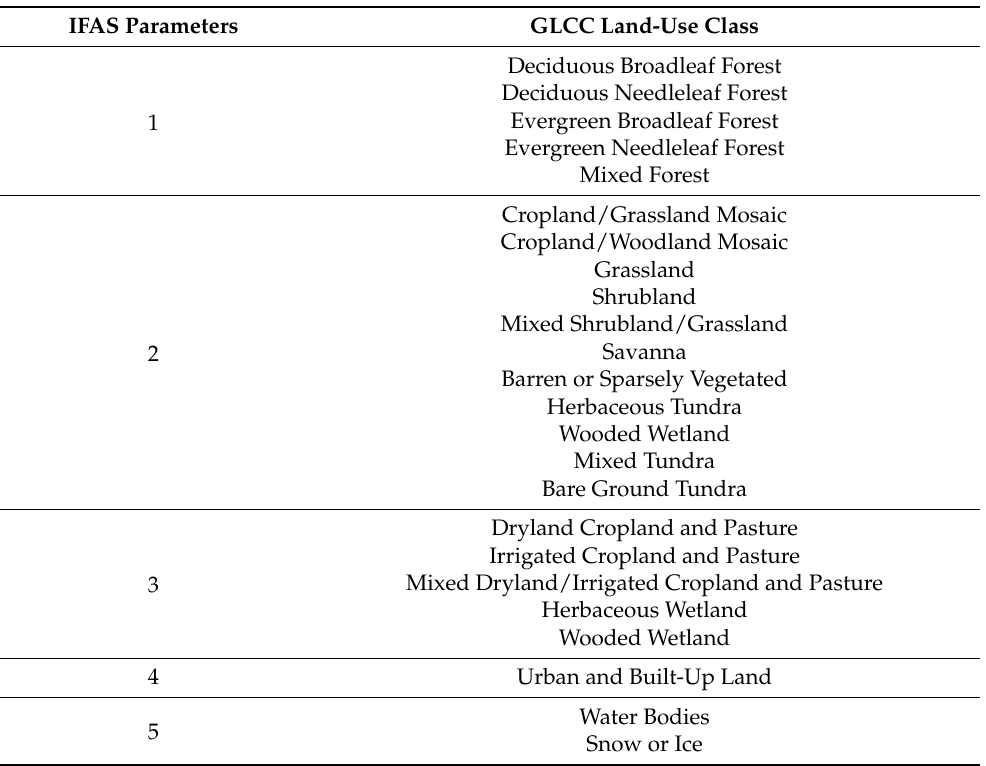
Table 1. Land-use classification of the CRB and its surface tank parameter in the IFAS. IFAS